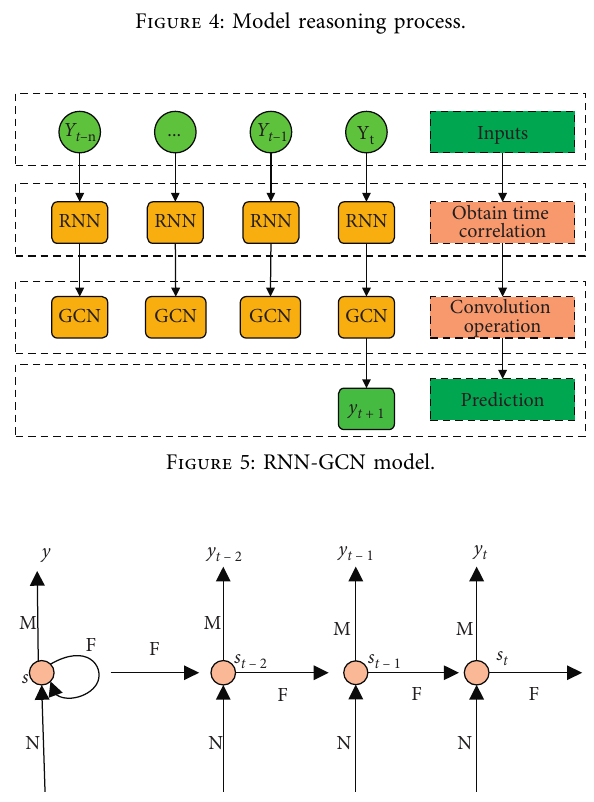
Figure 4: Model reasoning process.